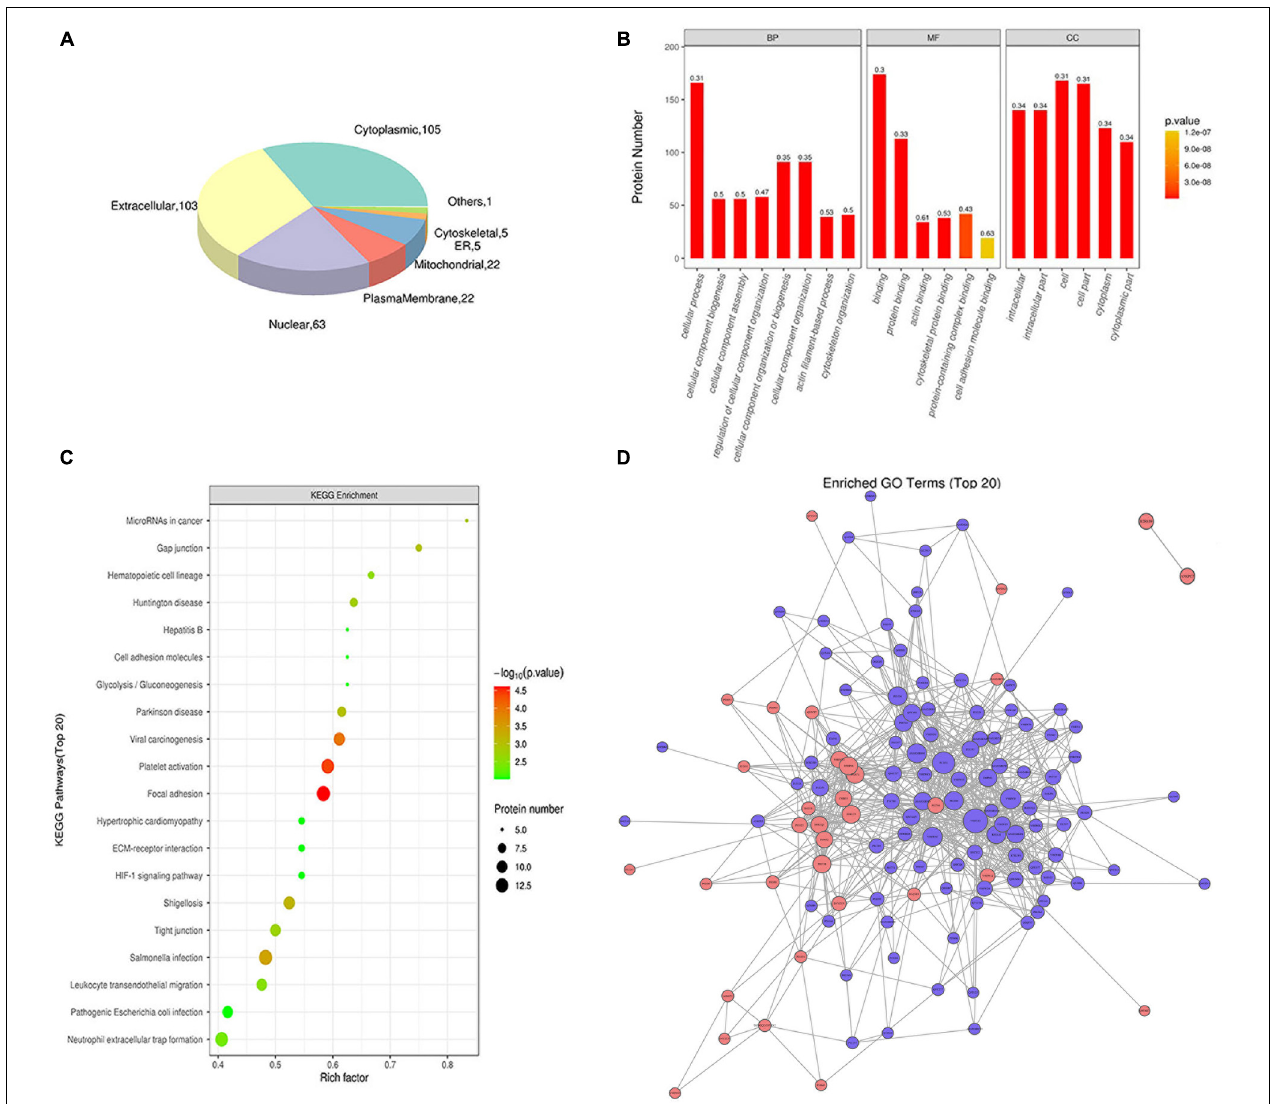
FIGURE 3 | Functional analysis of exosomes differential proteins. (A) Subcellular localization pie chart of differentially expressed proteins in two groups of exosomes (T vs. N). (B) GO enrichment map of exosomal differential proteins, including BP, MF, and CC. (C) Bubble diagram of KEGG pathway enrichment of exosomal differential proteins. (D) Interaction network of exosomes differentially expressed